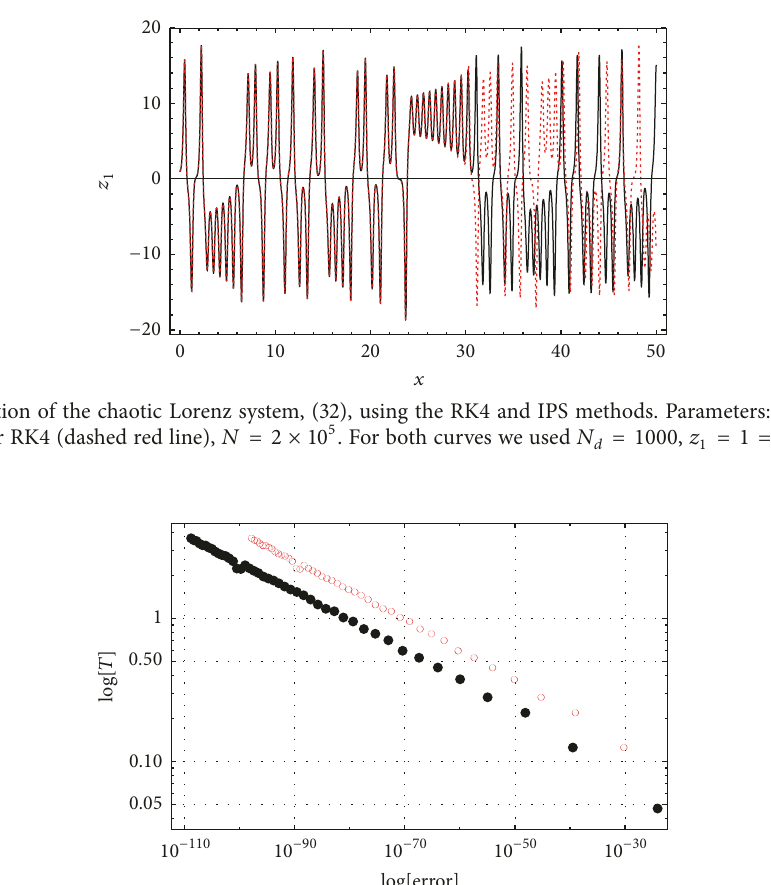
Figure 4: CPU time versus error on a log-log scale for the iterative power series solution of the NLSE, (29). Black filled circles correspond to error calculated from the difference between the power series solution and the exact solution. Red empty circles correspond to the error estimated by the formula (15). Parameters used: 𝑁 max = 50 , 𝑛 𝑑 = 500 , and 𝑁 ranges between 2 and